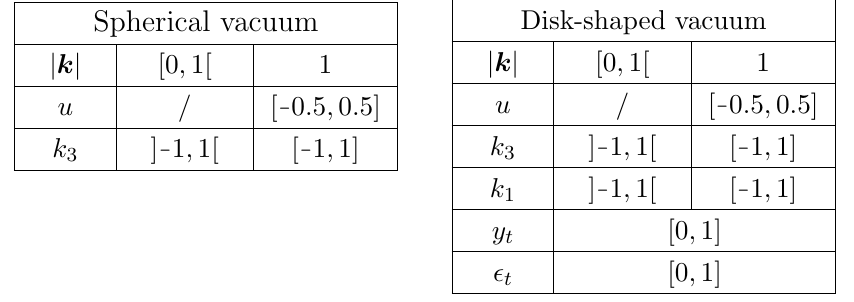
Table 2 . Ranges of the free parameters at the high scale, in the spherical and disk case. The value of the k i ’s are always chosen such that j k j (cid:20)